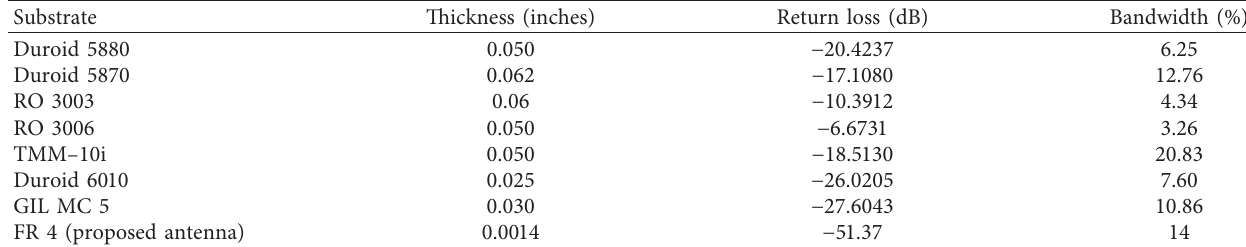
Table 4: Parameter comparison with the proposed